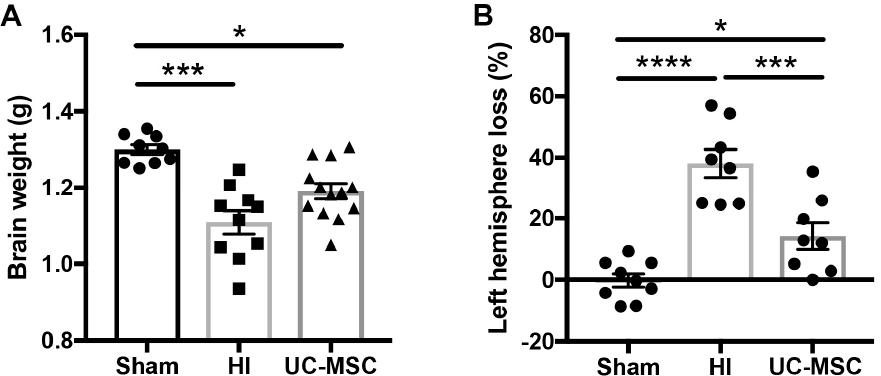
Figure 2. Neonatal hypoxic–ischemic (HI) brain injury results in tissue loss that is improved by intranasal UC-MSCs. ( A ) Brain weight ( n = 10–13 per group); ( B ) percentage tissue loss of the injured left hemisphere ( n = 8–9 per group). * p < 0.05, *** p < 0.001, **** p < 0.0001.